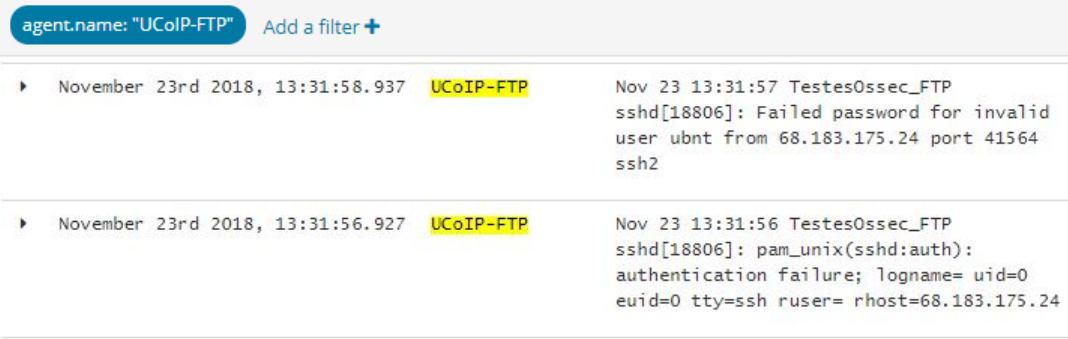
Figure 5. Layout of the Kibana UI